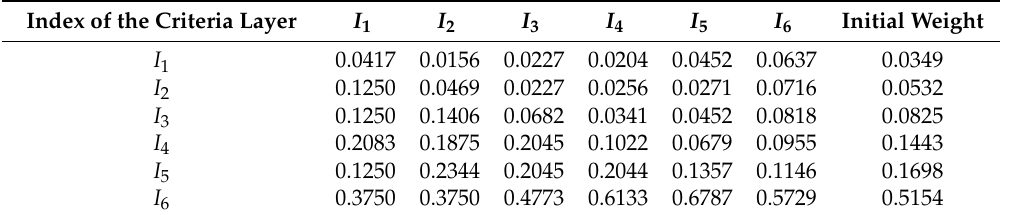
Table 6. Normalized judgment matrix and initial weight values of the criteria